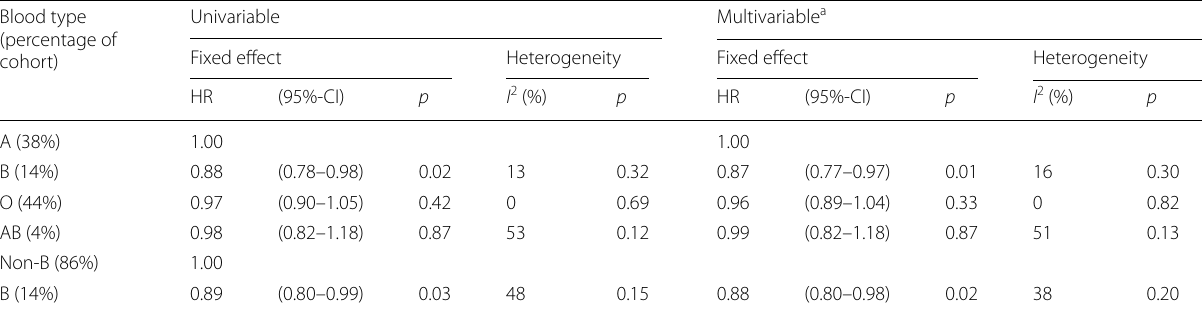
Table 3 The effect of ABO blood type on 30‑day mortality in critically ill patients—individual patient data meta‑analyses